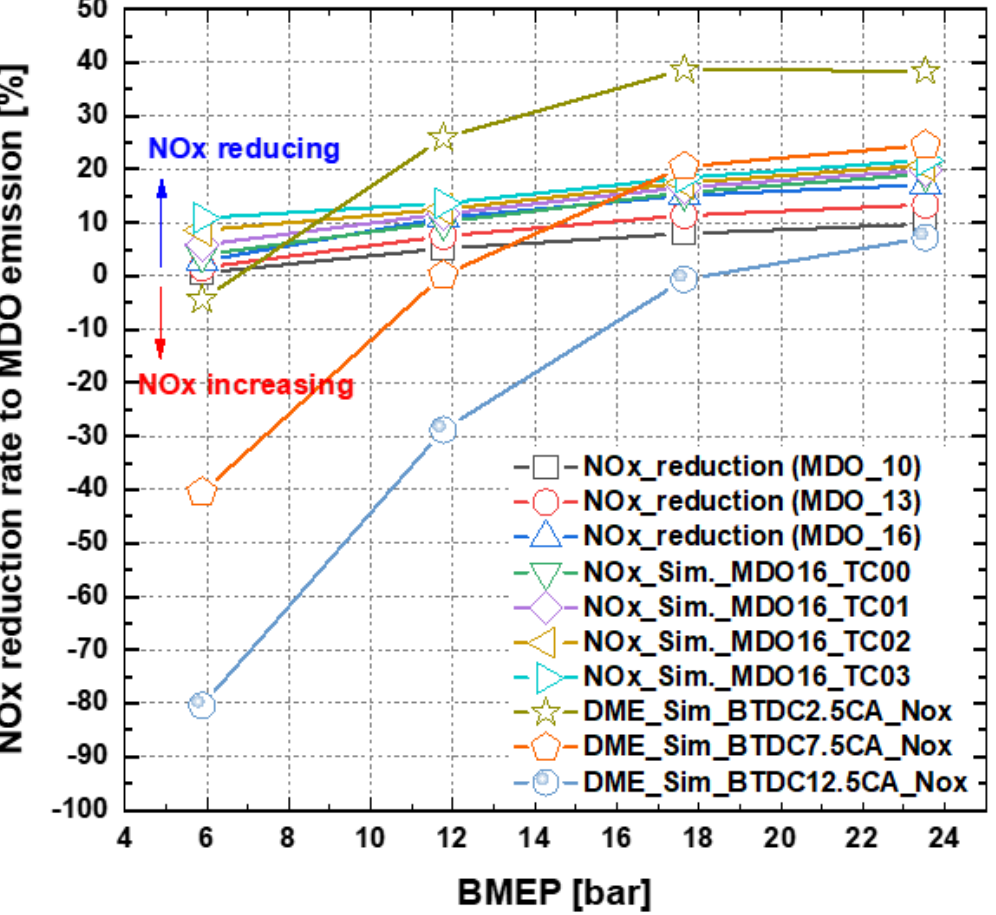
Figure 7. NO x reduction rate according to the MDO, EMDO, and DME fuels for the conditions of injection timing, turbocharger compression ratio, and moisture concentration.